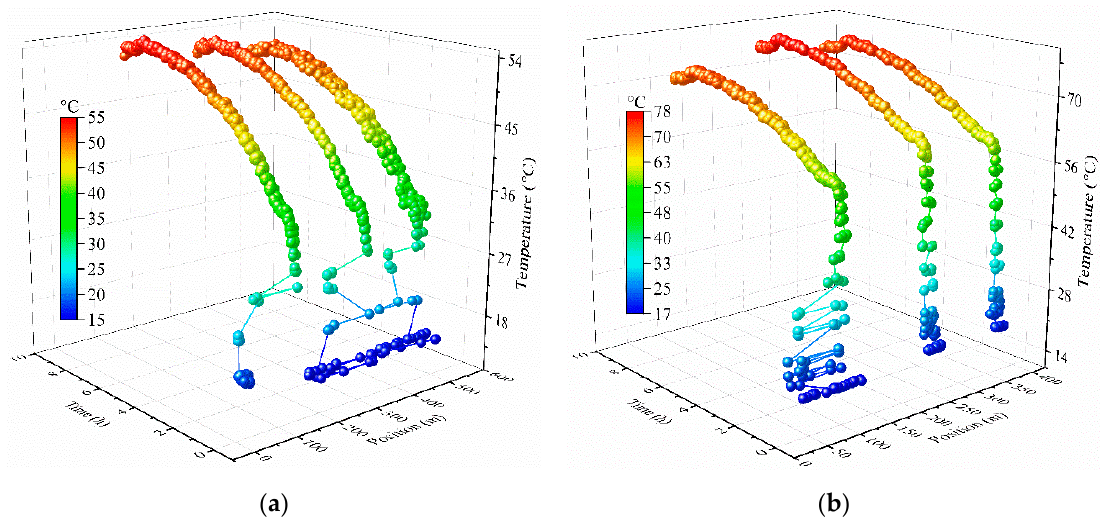
Figure 11. Hotspots trajectory of ( a ) HV windings and ( b ) LV windings.